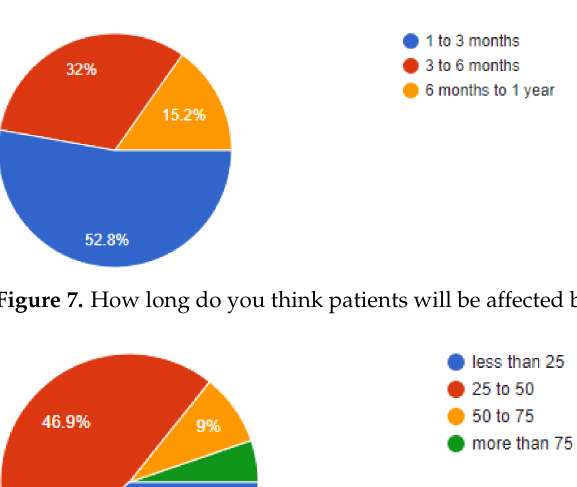
Figure 6. Carrying online consultations or not?